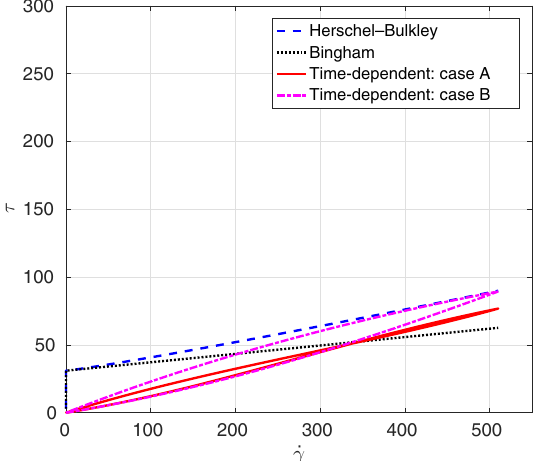
Figure 4. Analytical stress–strain for thixotropic avalanche case 1: shear stress (Pa) and rate of strain (s − 1 ) with τ 0 = 31Pa and τ c = 90Pa. The τ axis is scaled for comparison with Figs. 5 and 6, while the ˙ γ axis has an individual scale for clarity.